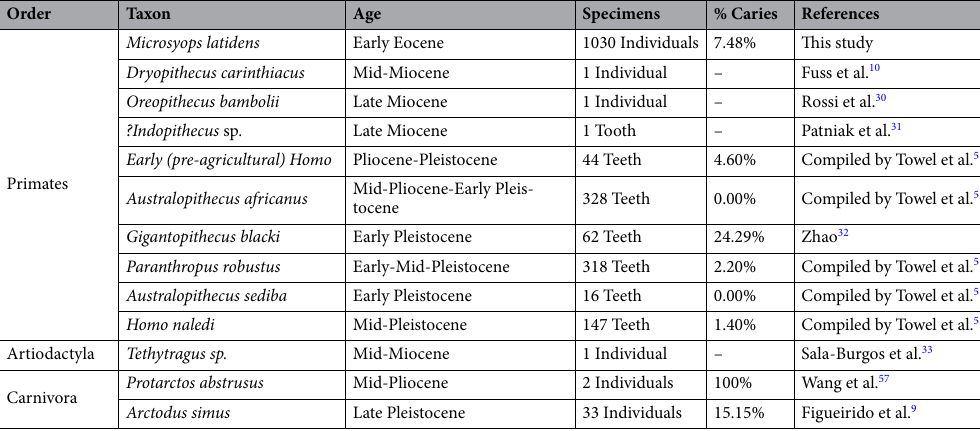
Table 1. List of fossil mammal species previously examined for the presence of dental